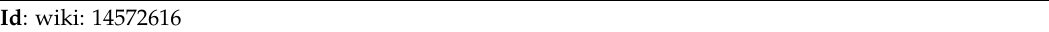
Table 2. Example of constructed pseudo-labeled